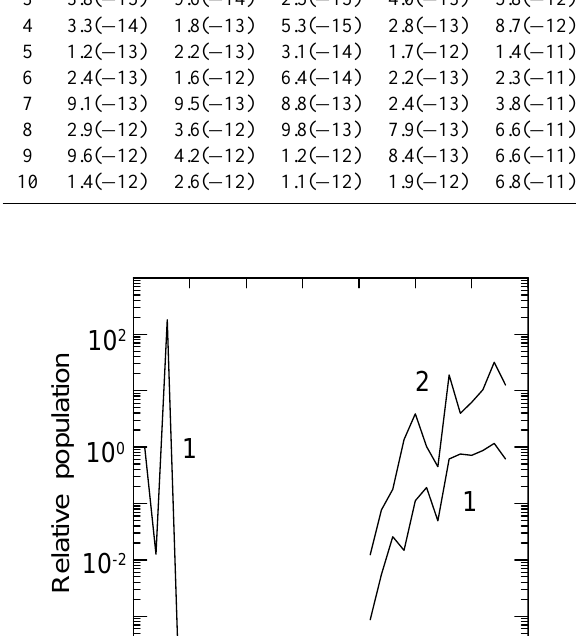
Fig. 15. The same as in Fig. 11, but for the b 1 6 + g state: 1 and 2 – without and with the contribution of processes